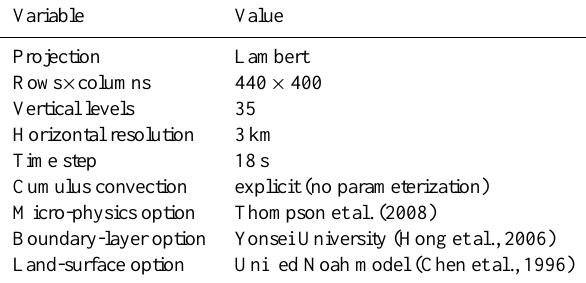
Table 2. Basic options of the numerical WRF